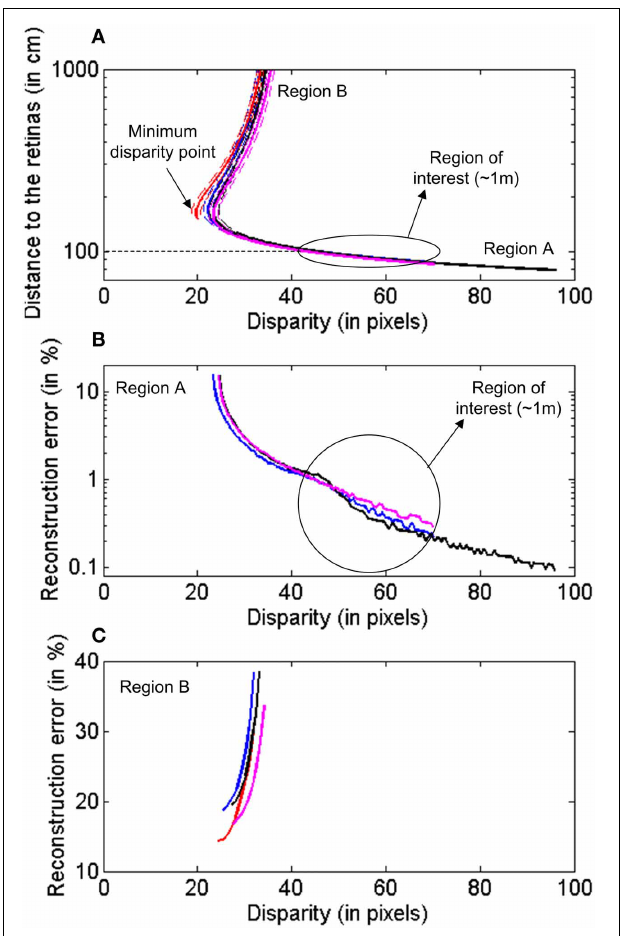
FIGURE 10 | Characterization of the 3D reconstruction of the epipolar lines for different pixels in Retina 1. Each color represents a different pixel. (A) Distance between the reconstructed points and the retinas for different disparity values. The dashed lines represent the upper and lower limits associated to the allowed deviation around the epipolar line. (B) Reconstruction error for 3D points closer to the retinas, Region A. (C) Reconstruction error for points farther from the retinas, Region B.